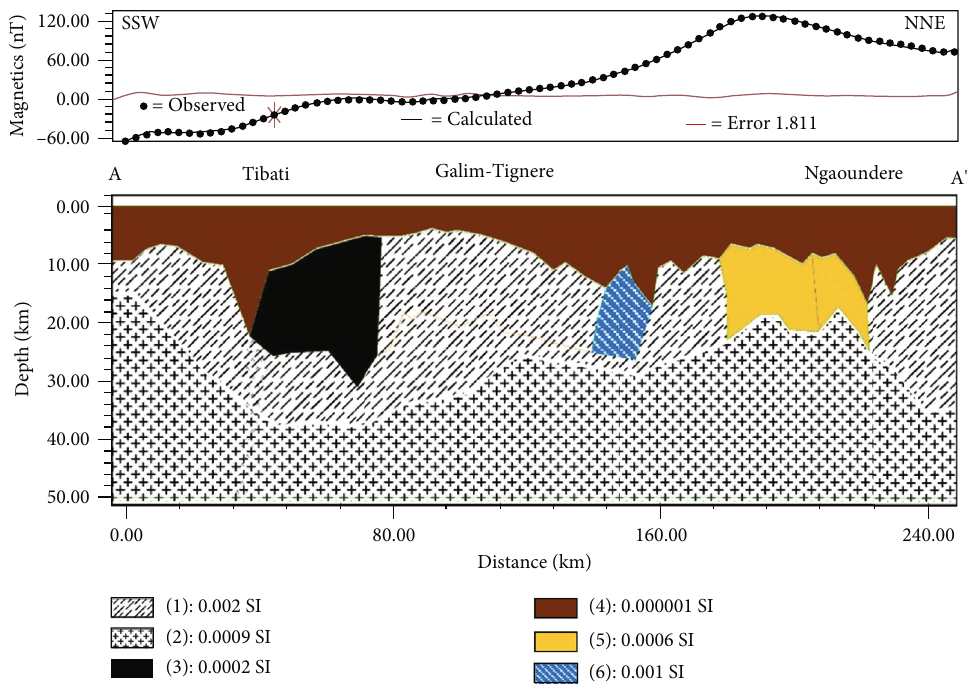
Figure 9: 2D magnetic modeling of A-A ′ pro fi le along SSW-NEE